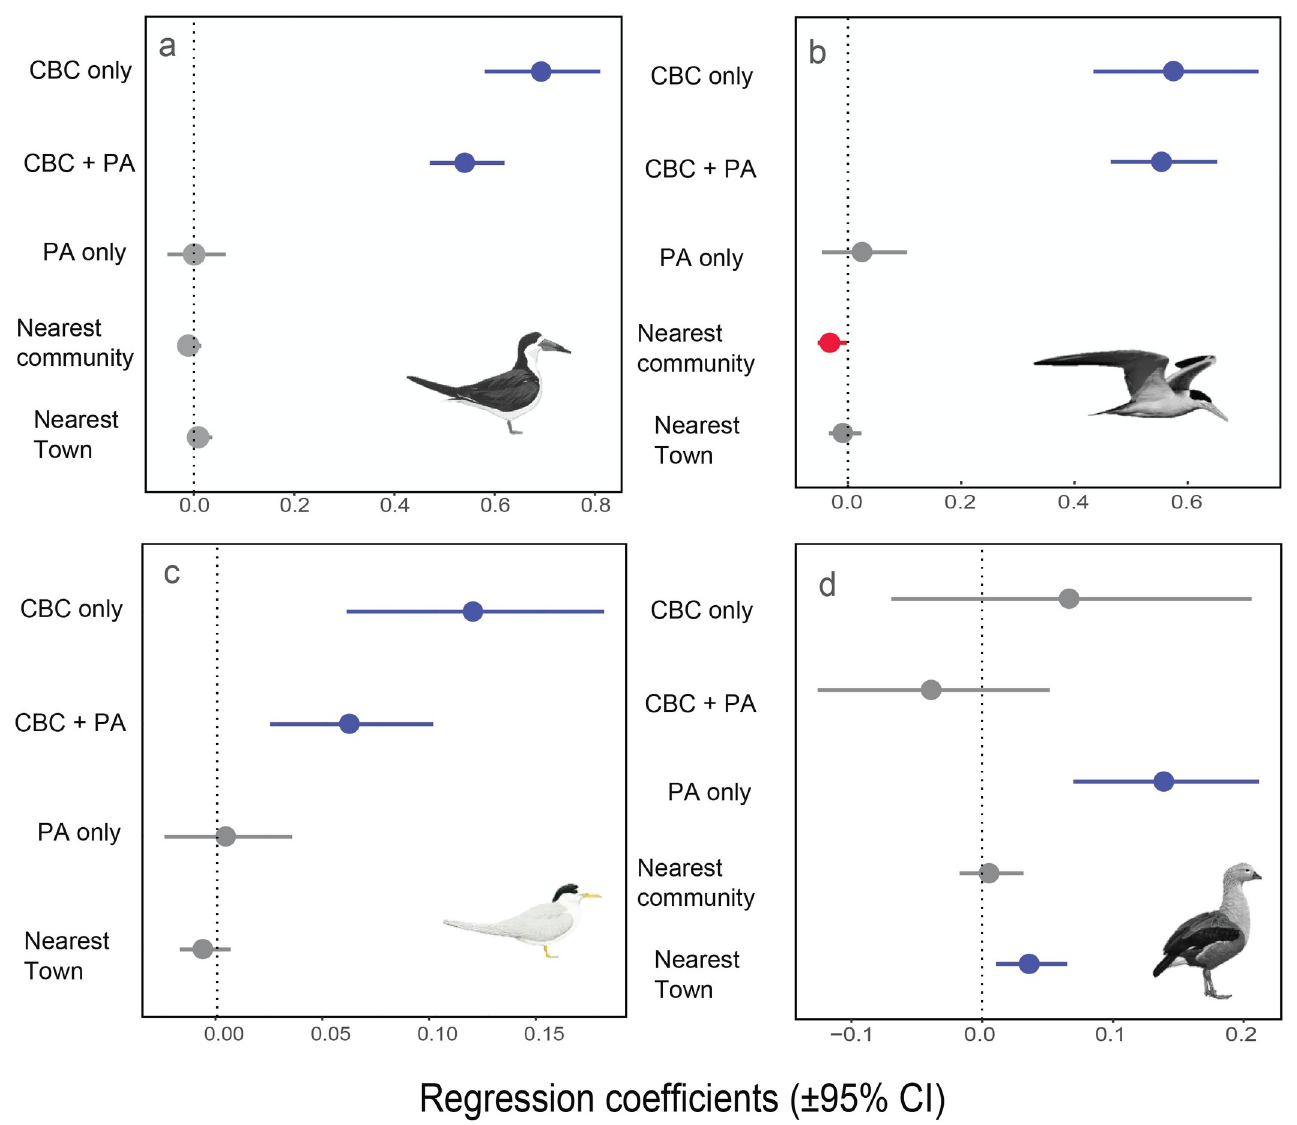
Fig 5. Coefficient estimates ( ± 95% confidence intervals) under the linear models, showing the magnitude and direction of effects of different variables on populations of four waterbird species surveyed along the Jurua´ River. (A) Black Skimmers, (B) Large-Billed Terns, (C) Yellow-Billed Terns, and (D) Orinoco Geese. For significant variables, the CIs do not cross the vertical dotted line at zero. Blue and red symbols represent positive and negative effects, respectively; gray symbols represent no effect.